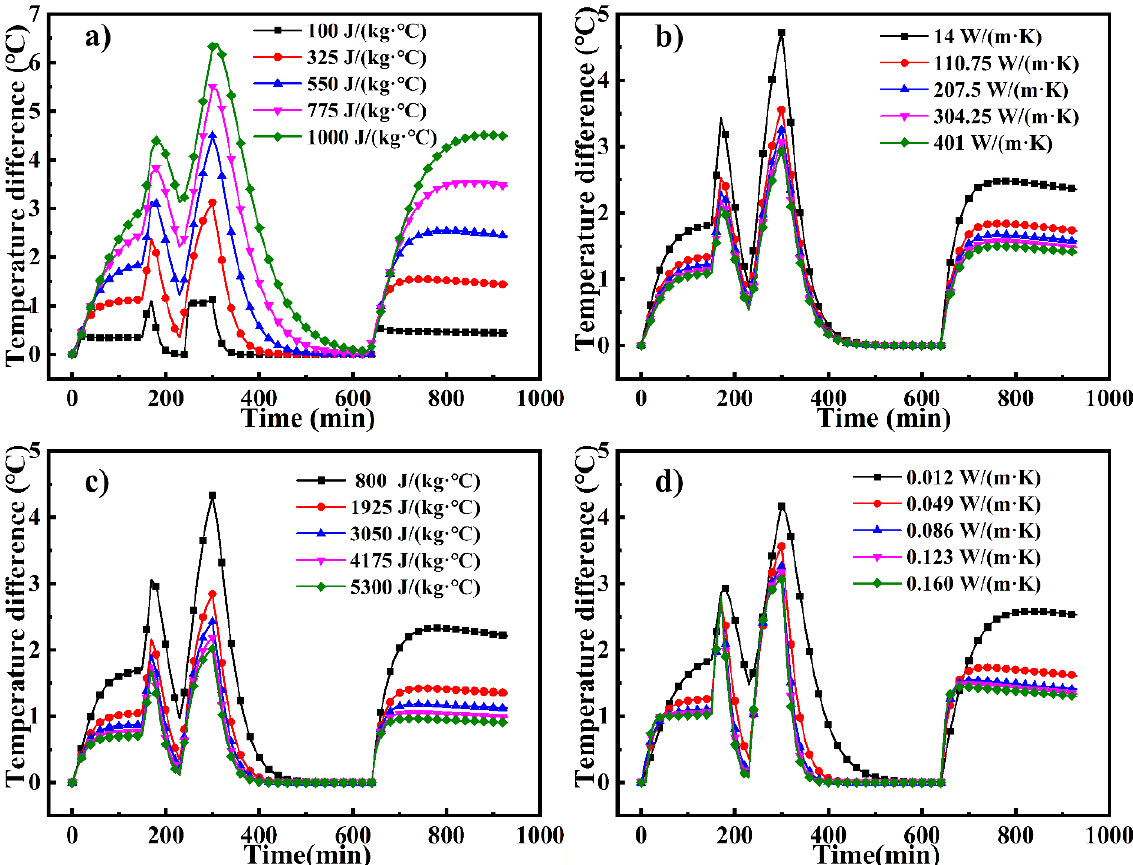
Figure 13. Maximum temperature difference on the mold plate as a function of ( a ) specific heat of the mold, ( b ) thermal conductivity of the mold, ( c ) specific heat of the fluid, and ( d ) thermal conductivity of the fluid. To describe the temperature distribution on the mold panel, all the temperature data at t = 300 min were projected along the length of the mold (Figure 14). Clearly, the tem- perature on the windward side of the mold is higher than that on the leeward side. As the specific heat of the mold decreases and the specific heat and thermal conductivity of the fluid increase, the T avg increases, and the temperature uniformity of the mold improves, as observed from the height of the temperature region. The thermal conductivity of the mold has a significant influence on the temperature uniformity but only a minor effect on the T avg and average heating rate. These conclusions corroborate the ones stated above.